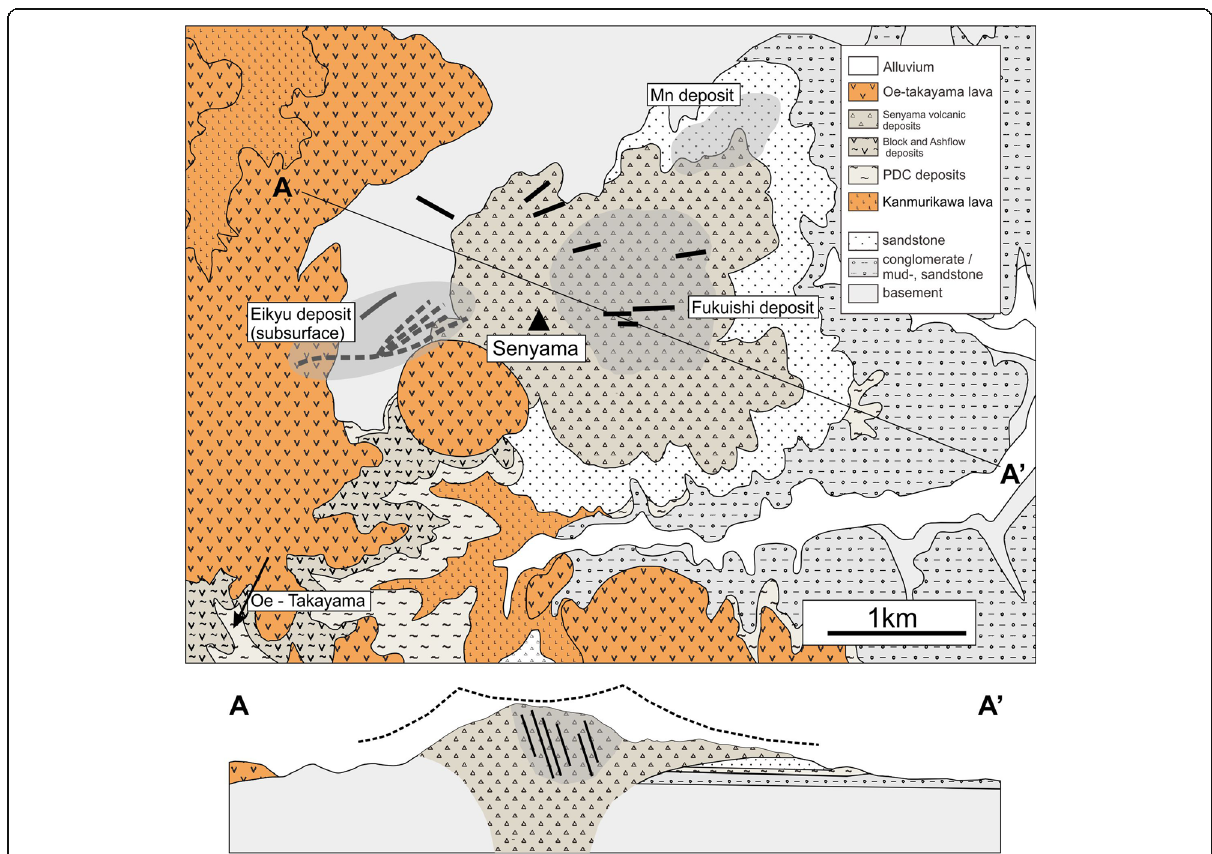
Fig. 11 Geological map and profile of the Senyama mountain (simplified after Kano, 2007). Senyama is a satellite cone of the larger O ’ e- Takayama, the oldest adakitic stratovolcanoe in the area. Senyama is notable for it ’ s rich silver occurrence which was mined during medieval times. Silver mineralization is associated with post-eruptive hydrothermal activity and alteration in the volcanic